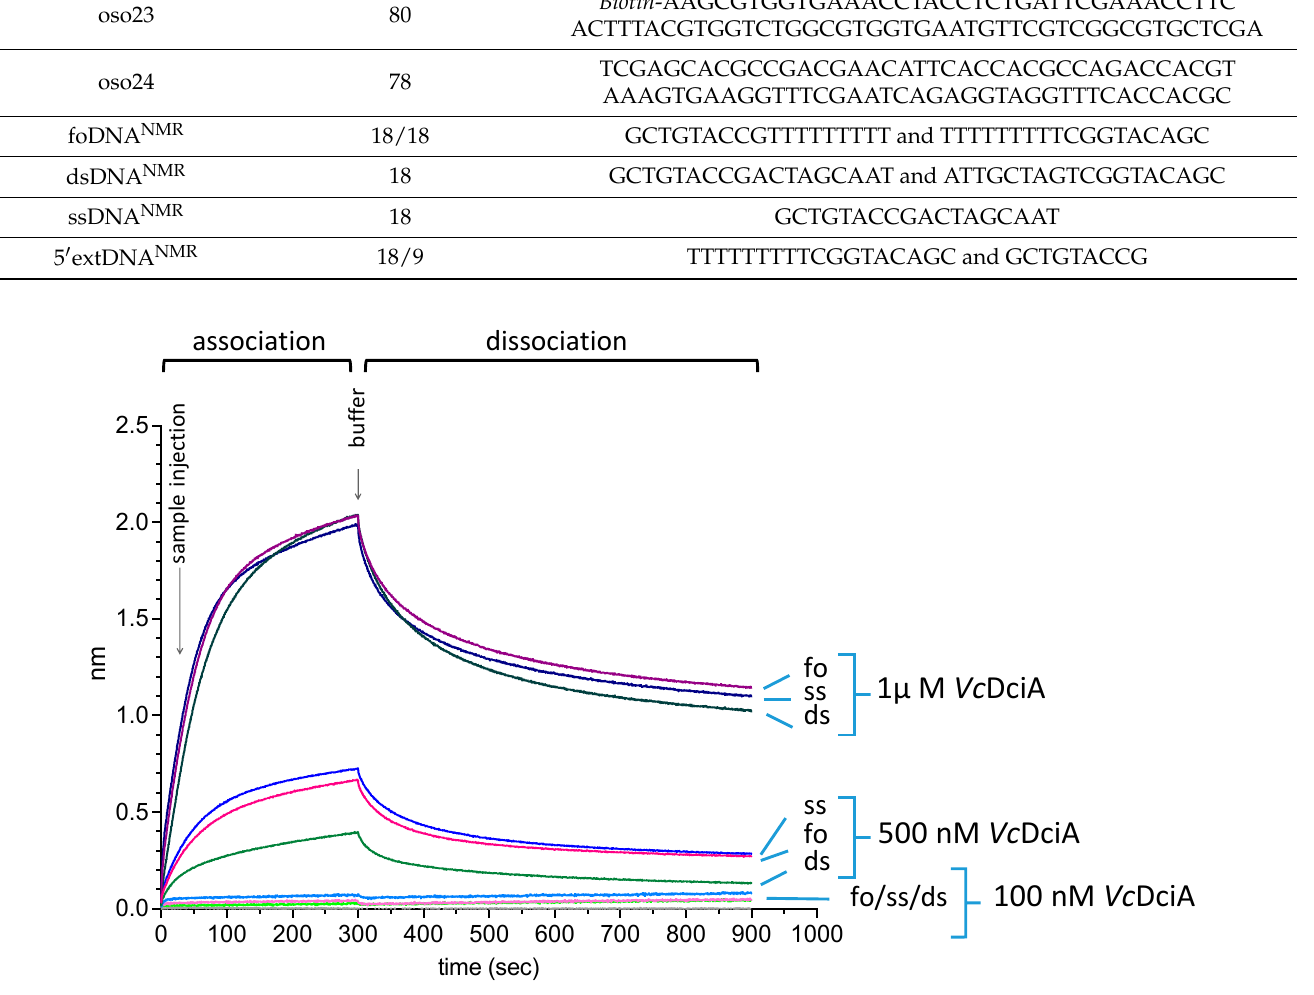
Figure 1. Interaction of Vc DciA with single- and double-stranded DNA, and with a fork-mimicking DNA, using BLI technology. An 80-base oligonucleotide (ssDNA) was attached via its biotinylated 5 ′ end to the chip before or after a prior hybridization step with complementary strands, to form the forked DNA (foDNA) or the double-stranded DNA (dsDNA) substrates (see Section 3). Vc DciA was injected at 3 concentrations on these 3 substrates in a buffer solution containing ATP.